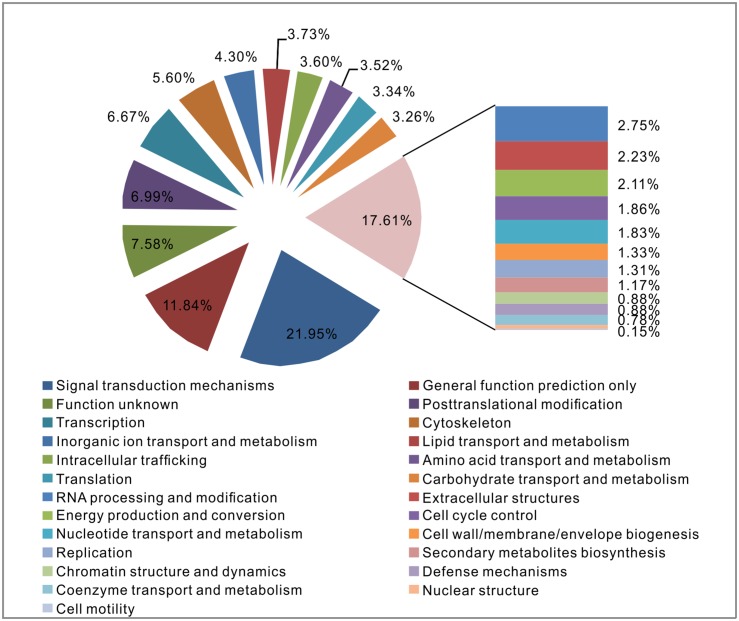
KOG functional classification.